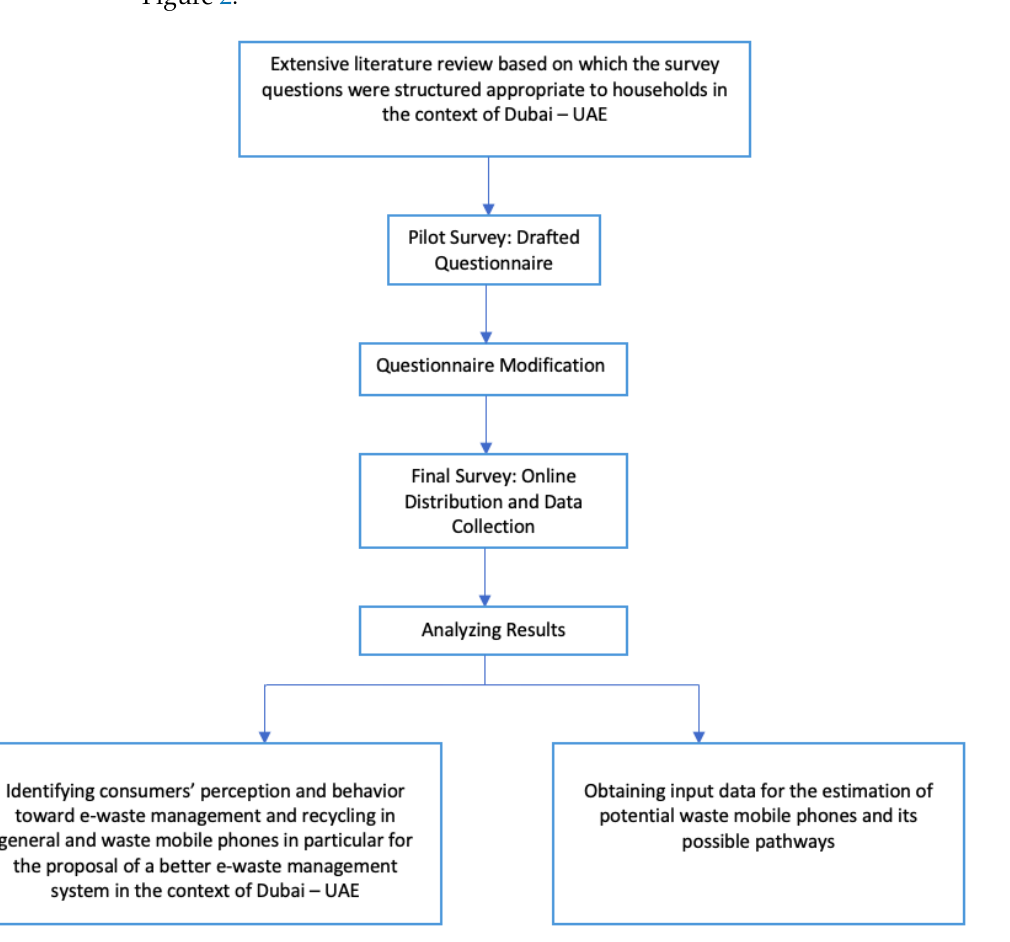
Figure 2. Survey Outline Overview.